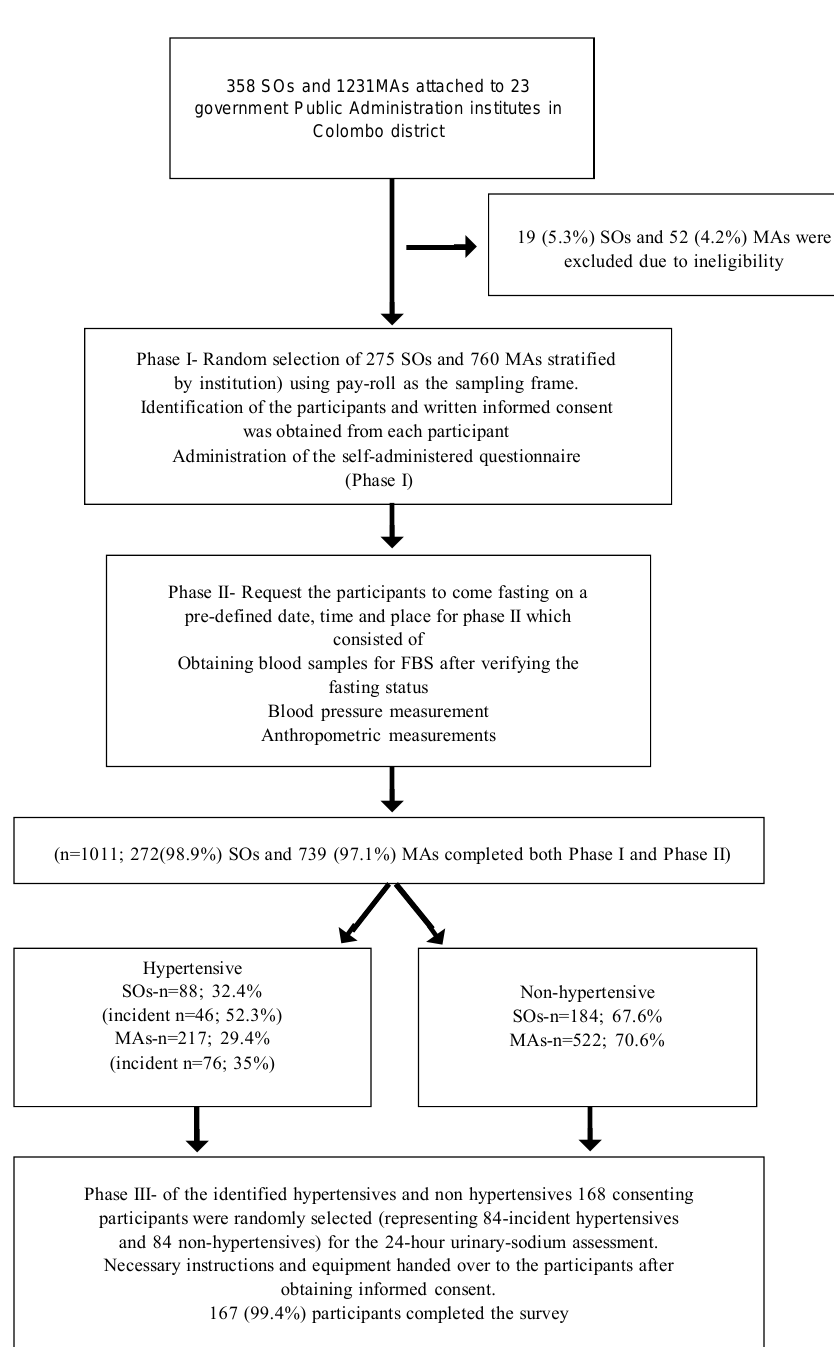
Figure 1. Flow diagram to illustrate the recruitment of the